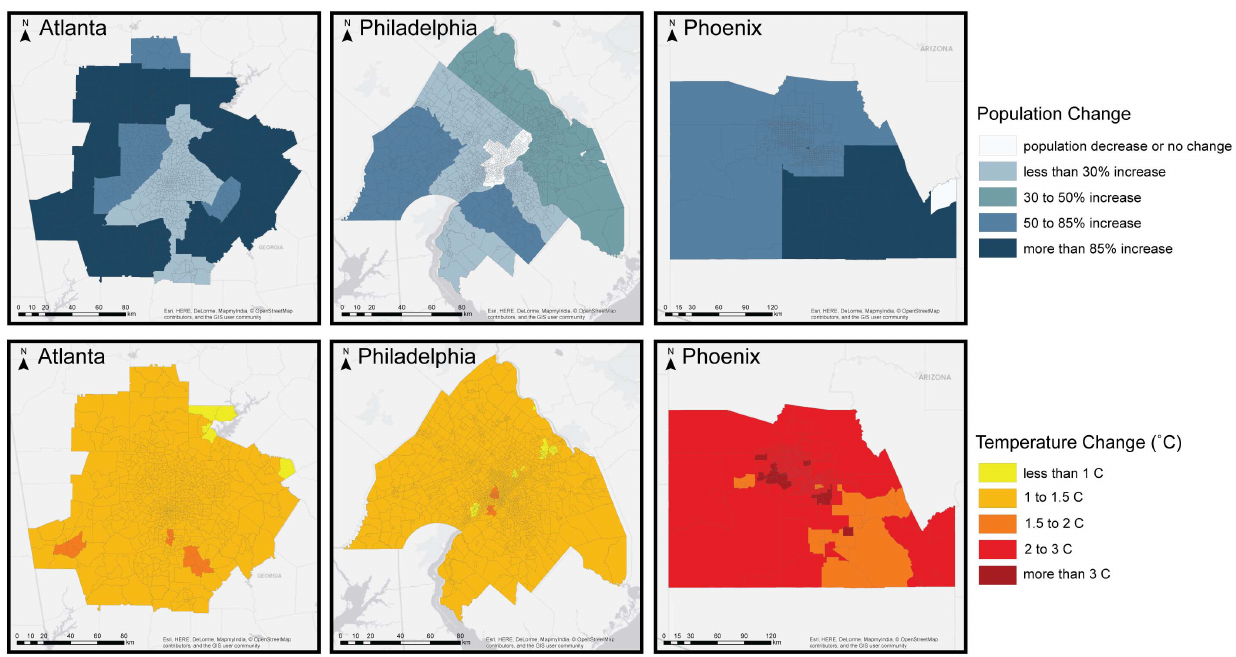
Figure 1. Change in population and average warm season (May – Sept) temperature under the BAU scenario between 2010 and 2050.